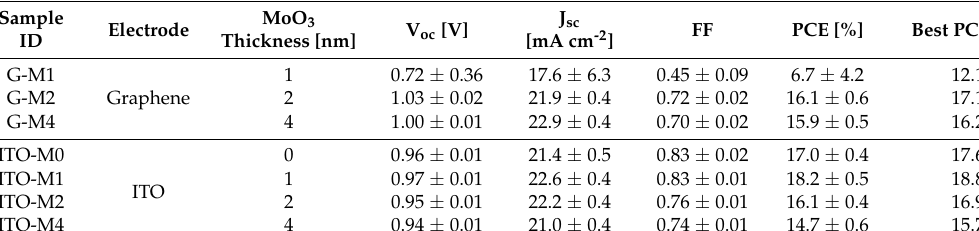
Table 4. Device parameters of PSCs with graphene/MoO 3 and indium-tin-oxides (ITO) electrodes [74]. Sample